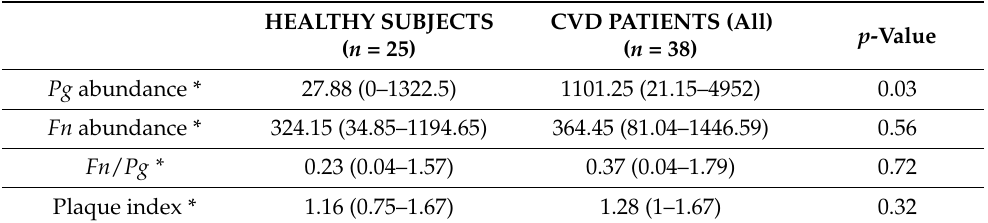
Table 6. Pg and Fn abundance: Comparison between healthy subjects and all patients with previously diagnosed CVD, after the exclusion of smokers.